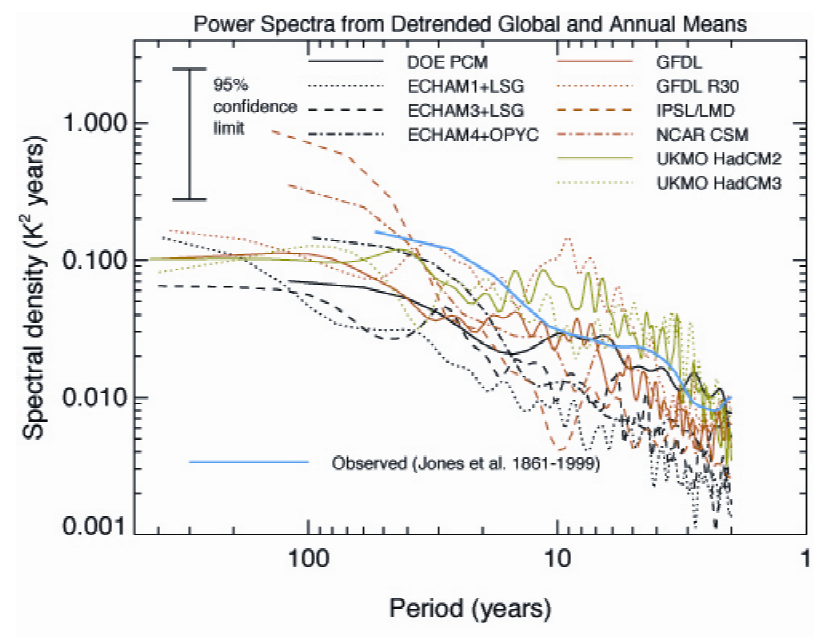
FIGURE 18. Power spectra of globally and annually averaged surface air temperature as simulated by the nine longest-running CMIP models. Observed curve was compiled by Jones for the IPCC WG1